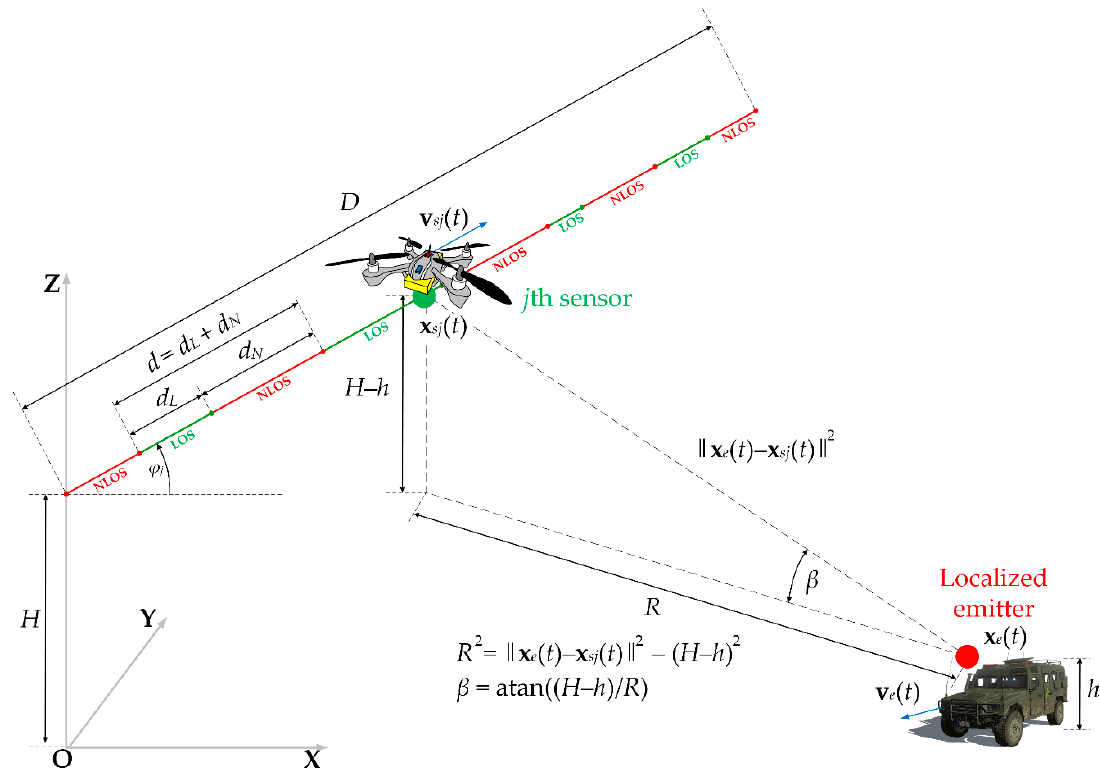
Figure 1. Spatial geometry of the simulation scenario for the selected sensor.